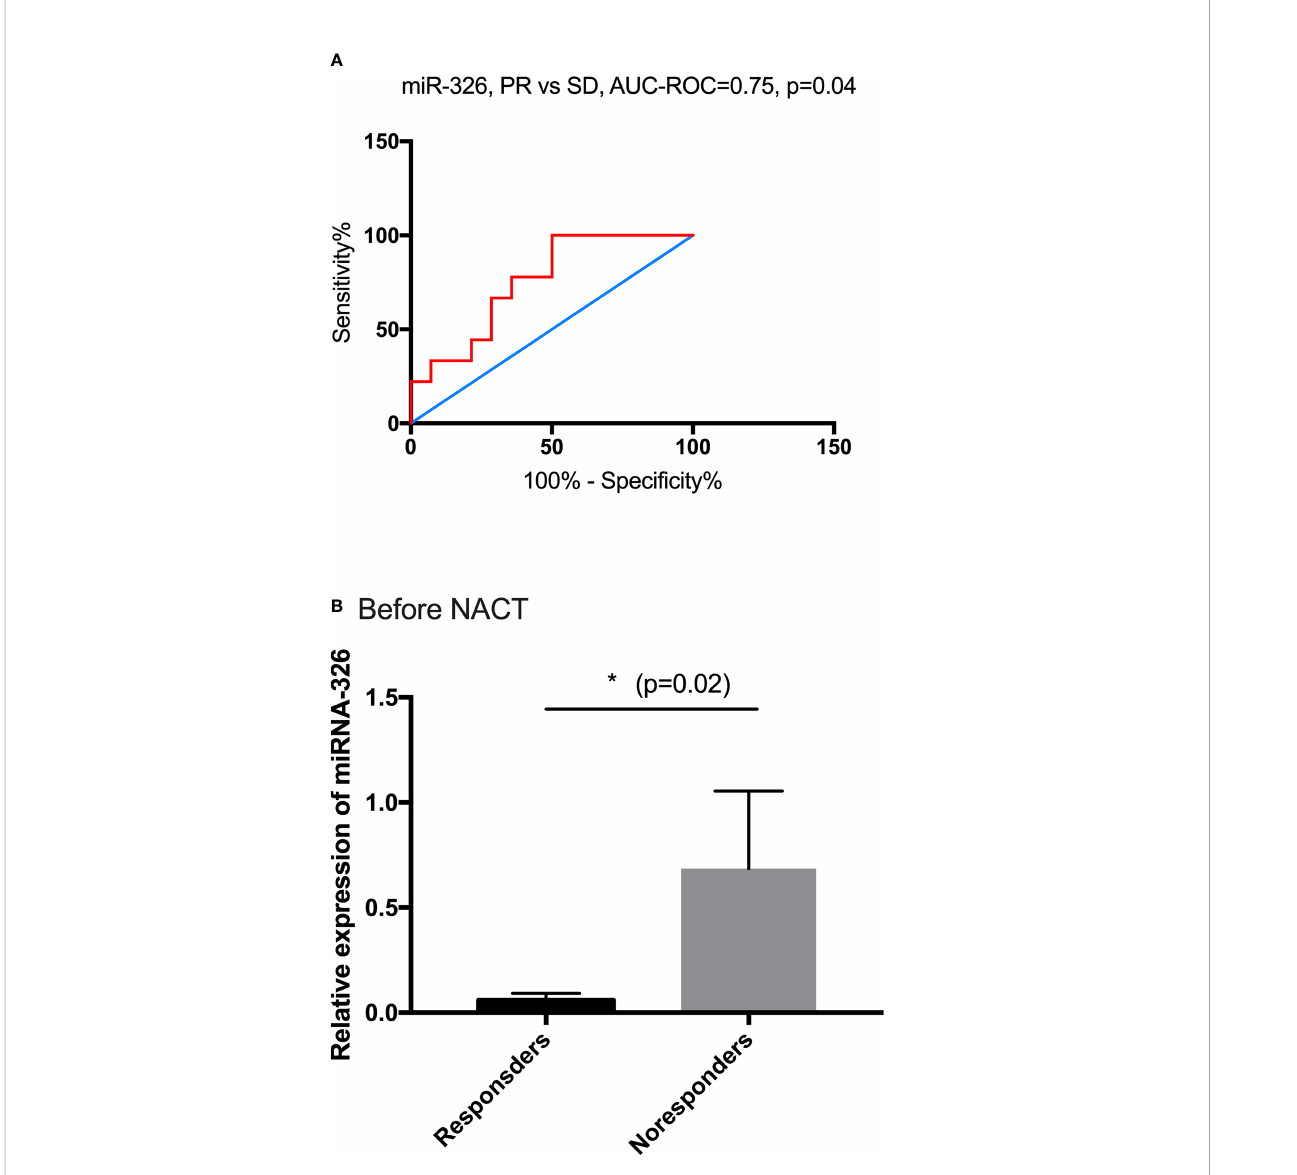
FIGURE 4 The predictive performance of miR-326. (A) The ROC curve for PR and SD based on the relative expression of miR-326, AUC-ROC = 0.75. (B) Before NACT, the baseline expressions of miR-326 in responders were much lower than those in non-responders ( p =